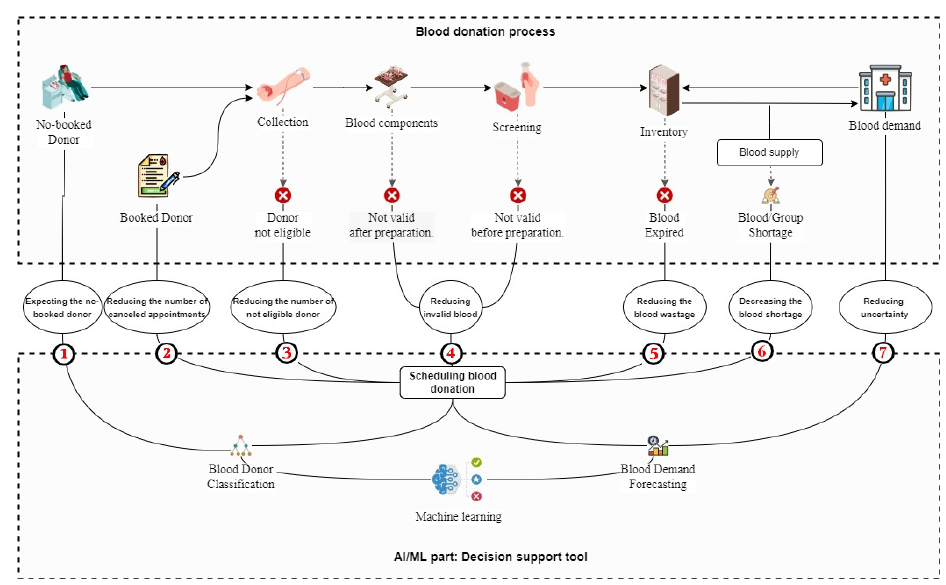
Figure 4. Flow diagram of the proposed